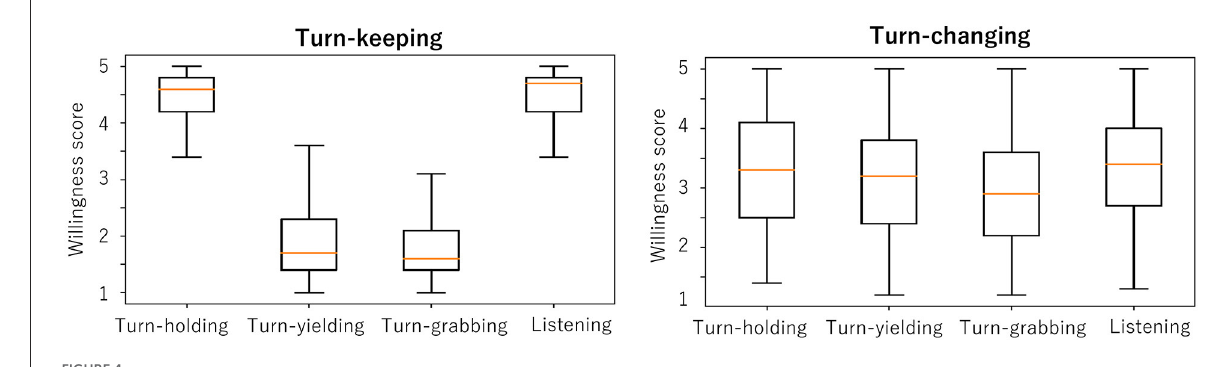
FIGURE4 Average willingness scores in turn-keeping (left) and turn-changing